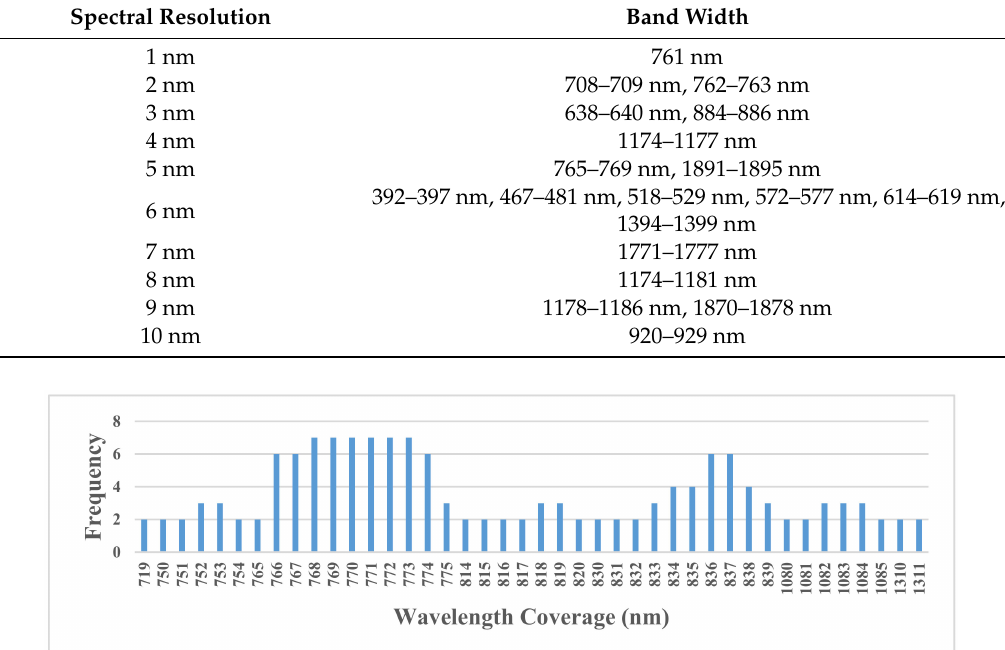
Figure 5. Frequencies of the input bands for the primitive wavelength for Cd